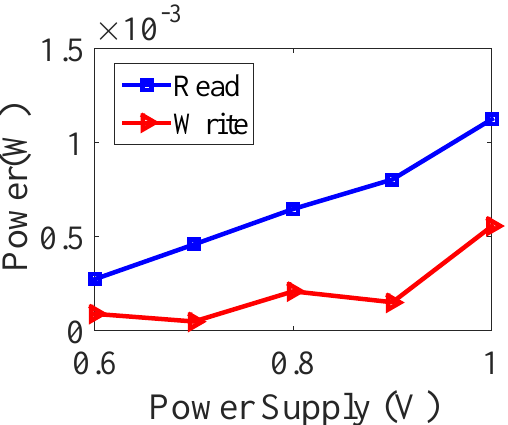
Figure 29. Dynamic power analysis for different supply voltages.